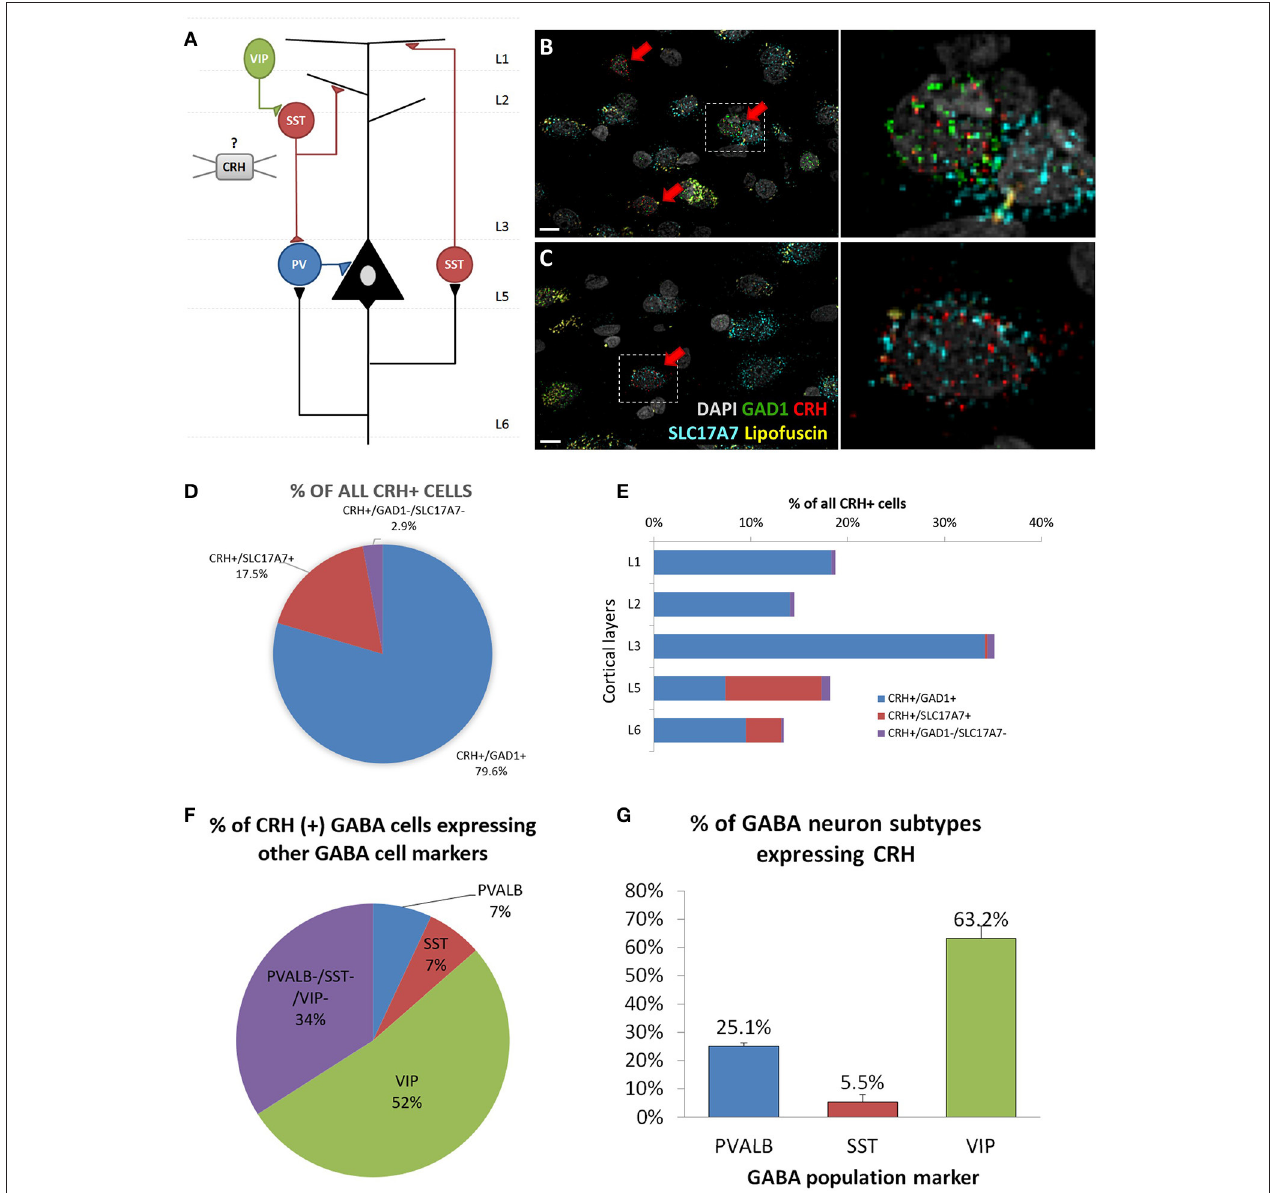
FIGURE 1 | Cellular identity of CRH expressing neurons in human sgACC. (A) Schematic of the cortical microcircuit. (B,C) Images of human subgenual anterior cingulate cortex (sgACC) labeled for SLC17A7, GAD1 and CRH mRNAs and counterstained with DAPI ( n = 8; scale bar: 10 µ m). (B) Many GAD1 + GABAergic interneurons in layers 1–3 co-express CRH. (C) Some SLC17A7 + glutamatergic cells in layer 5 co-express CRH. (D) The majority of CRH expressing cells in human ACC are GABAergic. (E) CRH + GABAergic interneurons are found across cortical layers while CRH + glutamatergic neurons are concentrated in deep layers. (F) 66% of CRH + neurons are overlapping with three major interneuron populations (52%: VIP, 7%: PVALB, 7%: SST) and 34% belongs to a separate subgroup of interneurons ( n = 5). (G) Percentage of 3 major interneuron subgroups that express CRH.